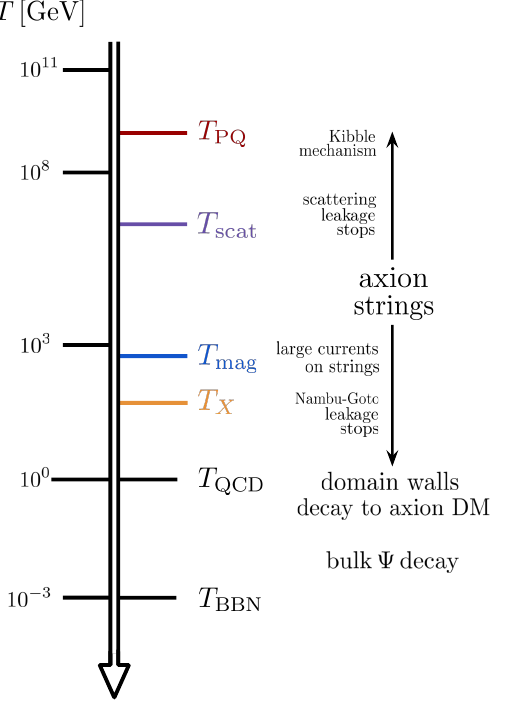
Figure 1 . The relevant scales in the evolution of superconducting axion strings. Besides the scales T scat and T X appearing in this section, we also include the scale T mag relevant for section 5.1. The temperature when the bulk Ψ decays is between m